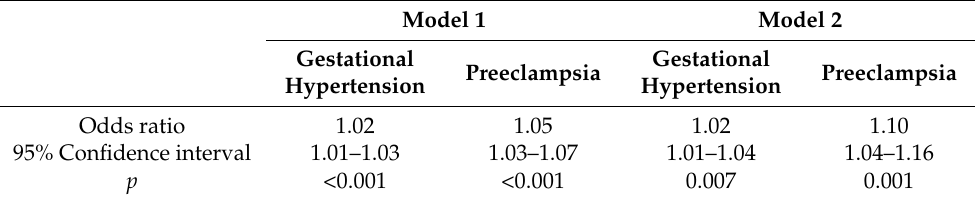
Figure 3. Total cell-free DNA (cfDNA) concentration in plasma of women who delivered at term ( ≥ 37 weeks of gestation) and those who delivered preterm (<37 weeks of gestation) ( A ). Total cfDNA levels in pregnant women who delivered normal growth newborns (NG, >10th percentile) and those who delivered fetal growth restricted newborns (FGR, < 10th percentile) ( B ). Box and whiskers are median {interquartile range, 5–95% percentile}. * p < 0.05 versus term or NG group based on Mann-Whitney test. Table 3. Multivariable logistic regression analysis for plasma total